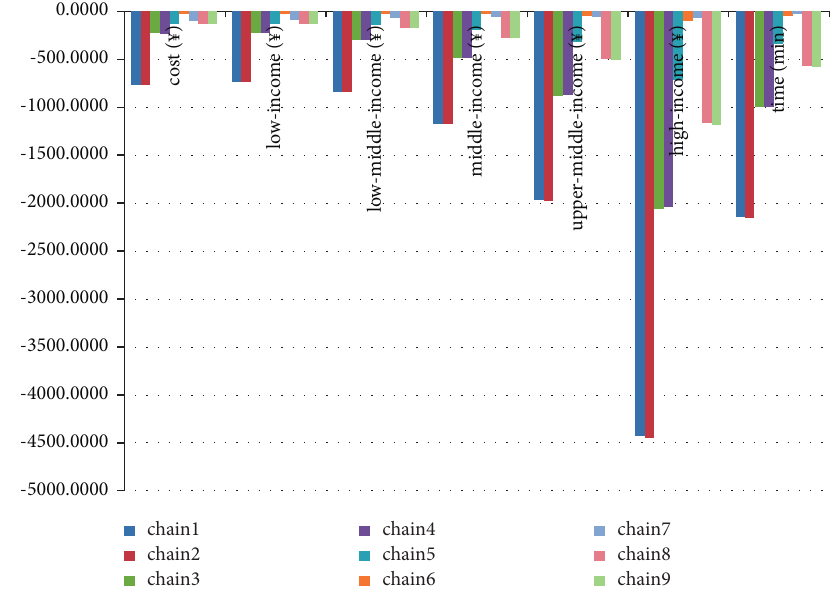
Figure 4: Comparison of the total of the optimal